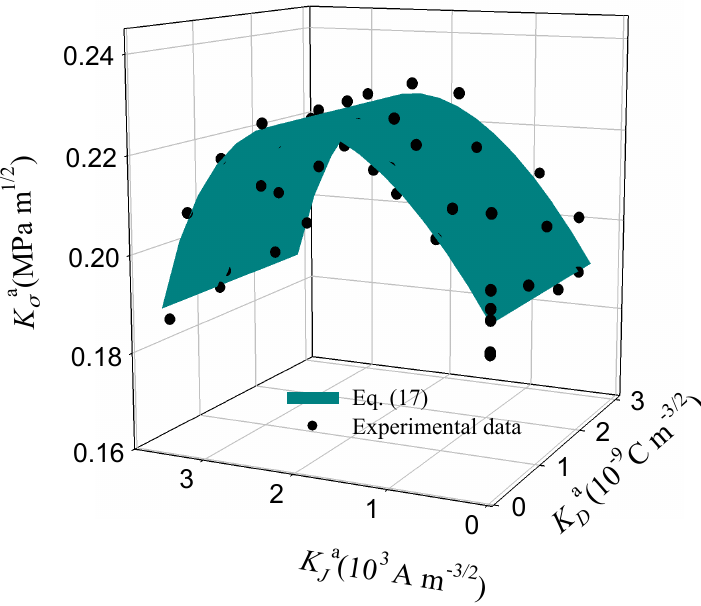
Figure 10. Experimental and fitting results for failure of PSCs specimens with a single-edge crack under combined mechanical and negative electrical loading.